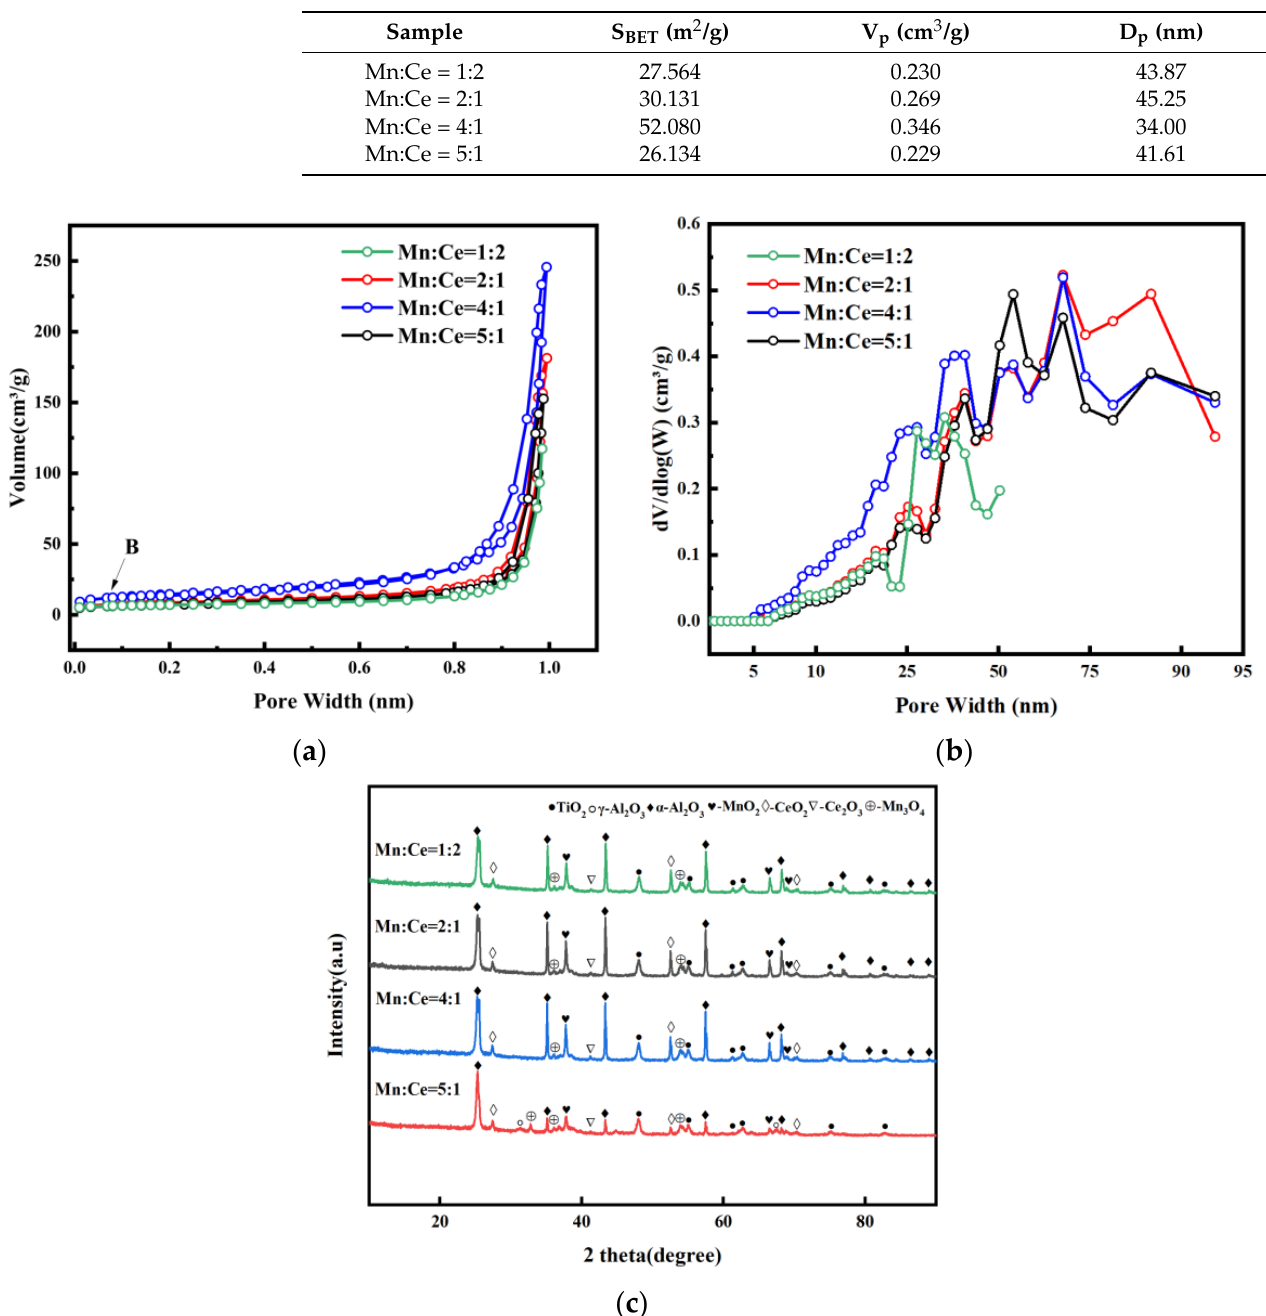
Figure 2. ( a ) N 2 adsorption and desorption isotherms of Mn-Ce/Al 2 O 3 /TiO 2 catalyst; ( b ) Pore size distribution curves of Mn-Ce/Al 2 O 3 /TiO 2 catalyst; ( c ) XRD patterns for Mn-Ce /Al 2 O 3 /TiO 2 catalyst.